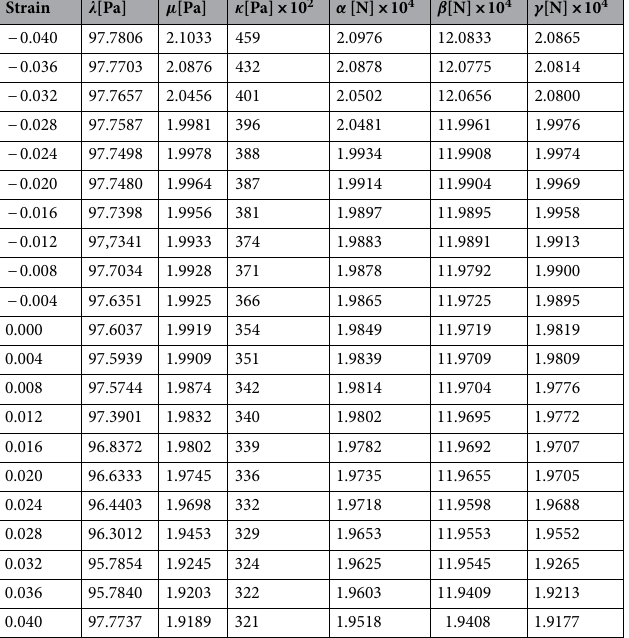
tion. A binary vector with 42 genes representing the real values of the parameters b j , j = 1, 2 . . . 42 , is used. The length of the vector is six places after the decimal point. The domain of parameters b j ∈ [− a j , a j ] with length 2 a j is divided into a least 15,000 equal size ranges. That means that each parameter b j , j = 1, 2 . . . 42 , is represented by a gene (string) of 22 bits 2 21 < 3000000 ≤ 2 22 . One individual consists of the row of 42 genes, that is, a binary vector with 22 × 42 components given by b